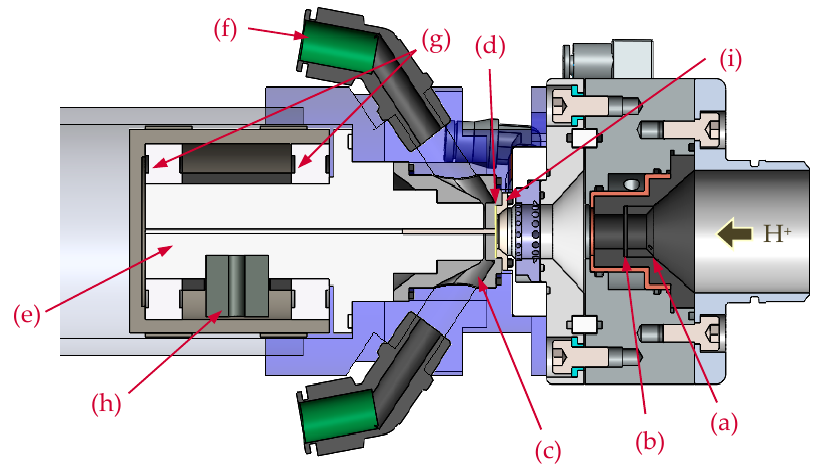
Figure 2. Schematic of 3D-printed sterling silver solid target: (a) 10 mm graphite collimator with removable crown; (b) graphite degrader; (c) 3D-printed SS925 target holder; (d) target material; (e) type-K thermocouple; (f) 8 mm ID water line; (g) ceramic bearings; (h) lead ballast; (i) magnetically coupled Nb front cover.